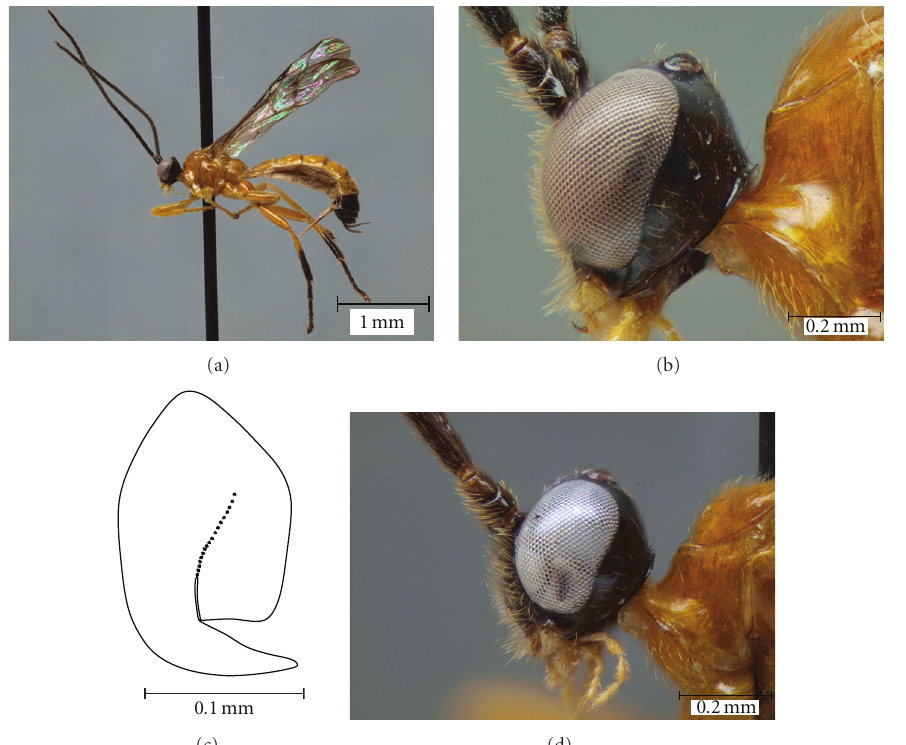
Figure 1: T. amazonica sp.n.: holotype female habitus (a), occiput detail (b), fore tarsal claw (c), and paratype male occiput detail